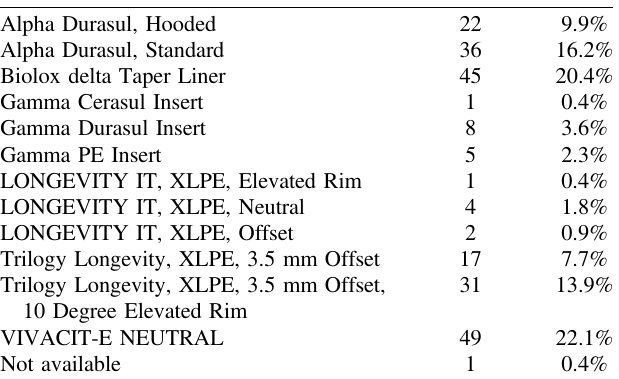
Table A.3. Acetabular liner used.